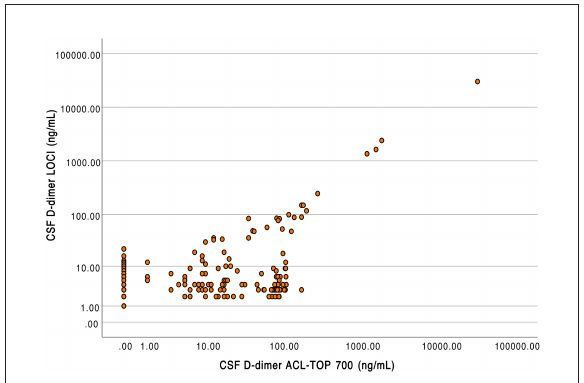
FIGURE4 Scatterplot of D-dimer concentrations in cerebrospinal fluid measured using luminescent oxygen channeling immunoassay (LOCI, y-axis) and latex-enhanced turbidimetric immunoassays (HemosIL HS 500 reagent) on the ACL TOP 700